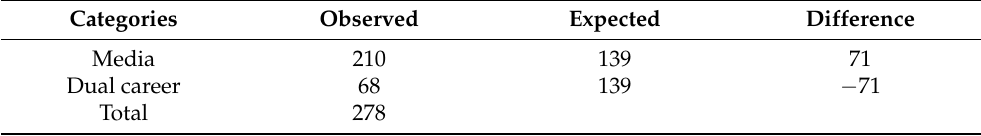
Table 4. Observed frequencies and expected frequencies for the variables “mass media” and “dual career.”